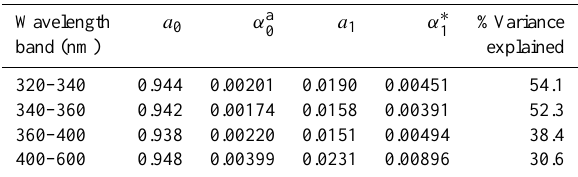
Table 4. Results from the regression model: